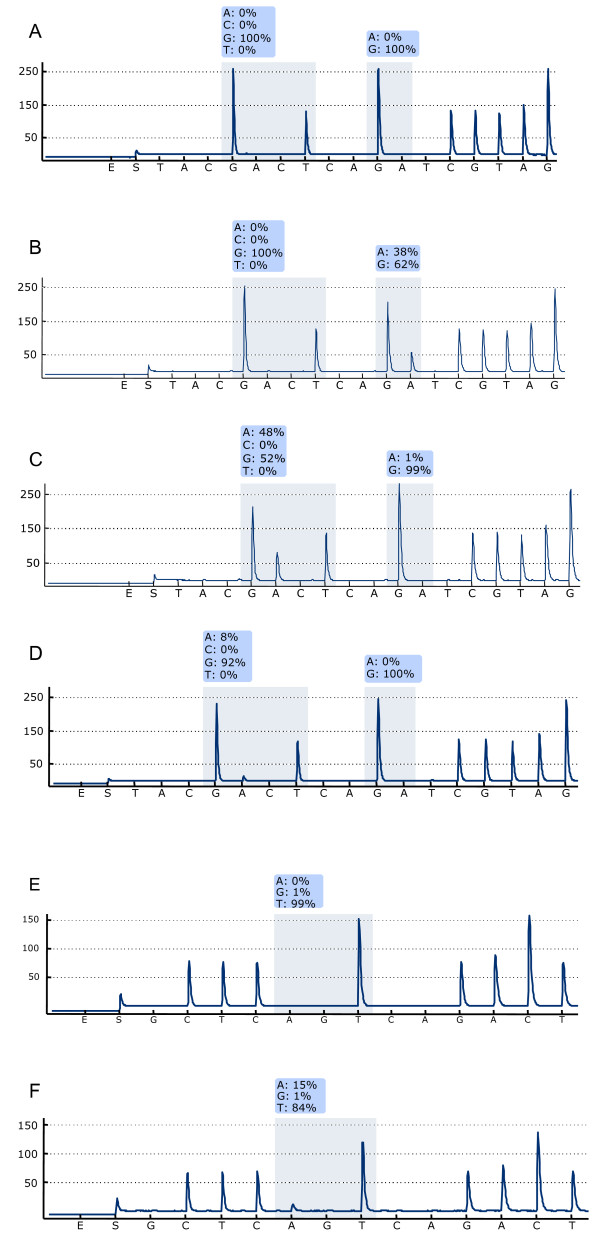
KRAS analysis by Pyrosequencing. Representative examples of Pyrosequencing KRAS analyses of codons 12 and 13 (A-D) and codon 61 (E-F). Codon 12, 13 wt (A); codon 13 mutation GGC>GAC (B); codon 12 mutation GGT>GAT (C); codon 12 mutation GGT>GAT in DNA from tissue with less than 10% tumor cells (D); codon 61 wt (E), and codon 61 mutation (F).